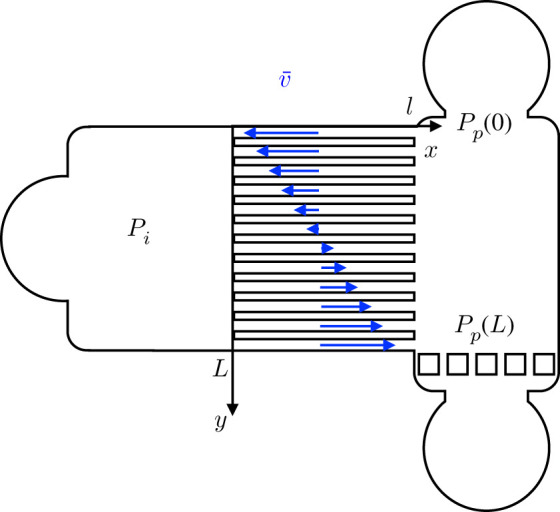
Sketch of the device. The blue arrows indicate the direction and amplitude of the fluid velocity in the parallel microchannels.